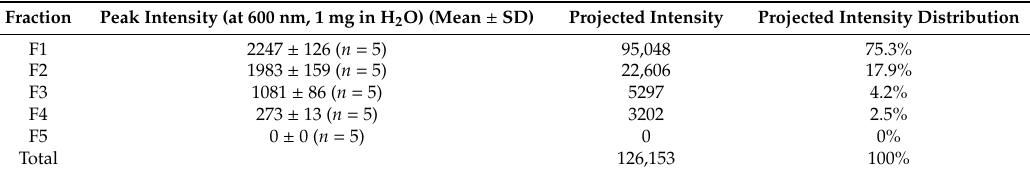
Figure 7. Fluorescence output from RPE granules. F1 had the highest fluorescence intensity counts per mg granules ( a ). A progressive decline of fluorescence intensity is seen from F2 to F4 ( a ). The projected fluorescence output from F1 is 75.3% of the total projected fluorescence output ( b ), (Table 3). Fraction F3 contributes only 4.2% to the total projected fluorescence output ( b ), (Table 3). Table 3. A2E contents and